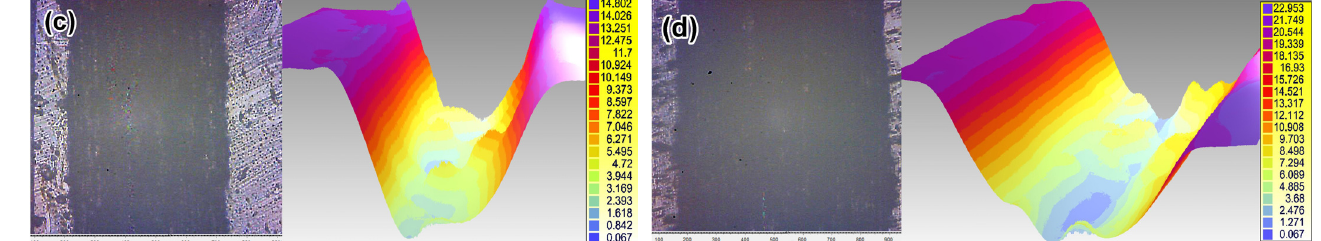
Figure 13. Wear tracks in plane and their 3D images after dry sliding: ( a , b ) as-received specimens, ( c , d ) plasma-treated specimens (( a , c ): plate 316T; ( b , d ): LPBF 316L) (the bar values are given in μ m).